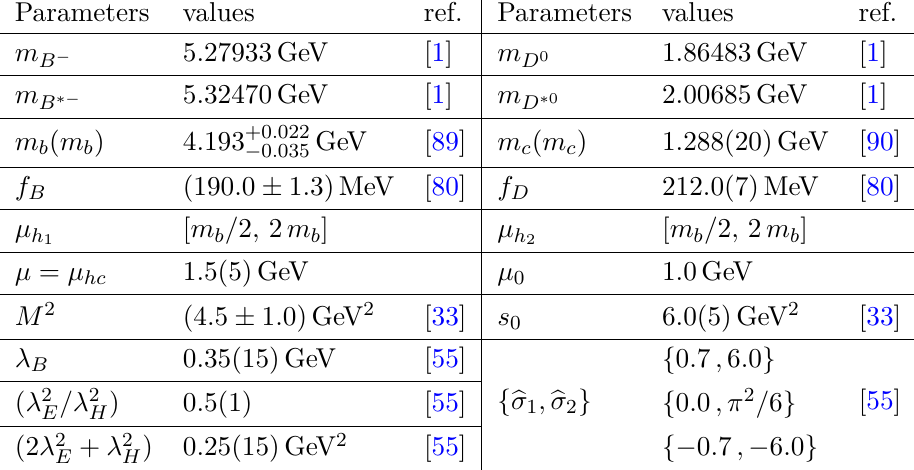
Table 1 . Parameters used for the numerical analysis. logarithmic moments of the leading twist DA with explicit definitions given in (D.12). λ parameterize the matrix element of the local antiquark-gluon-quark operator (D.8). The quark masses are in the MS -scheme evaluated at the scale of their MS